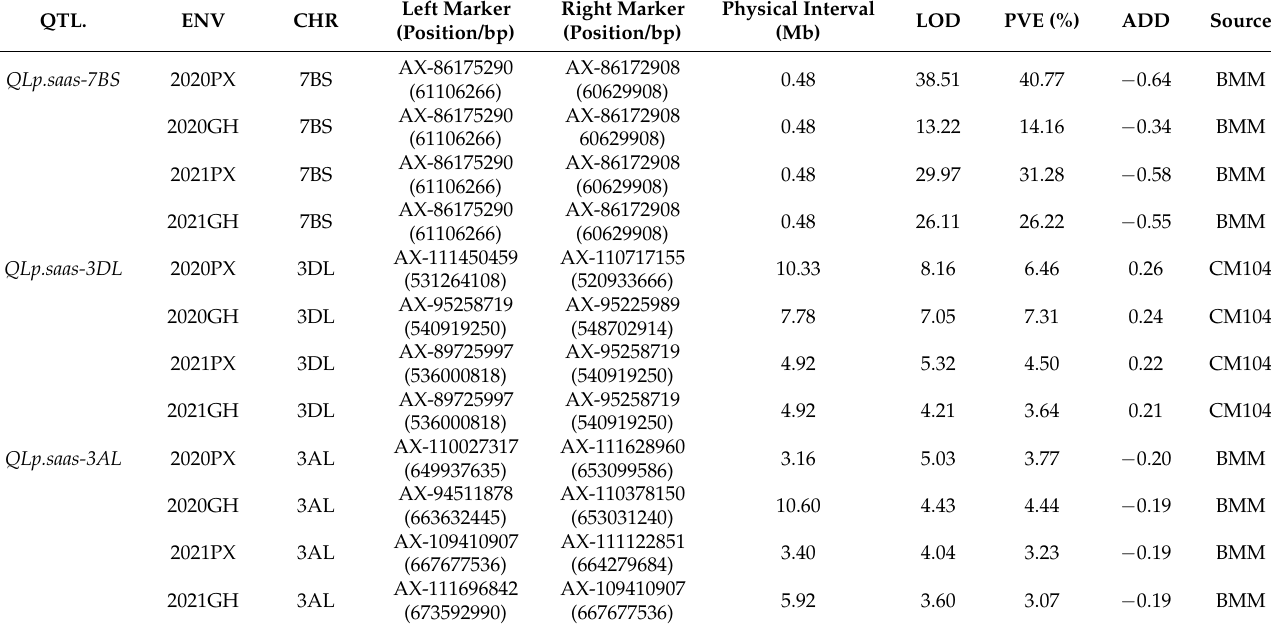
Table 2. QTLs for leaf pubescence by inclusive composite interval mapping in the recombinant inbred lines population of Chuanmai104 × Baimaomai in four environments. The physical position of markers is in relation to the Chinese Spring reference genome (IWGSC RefSeq